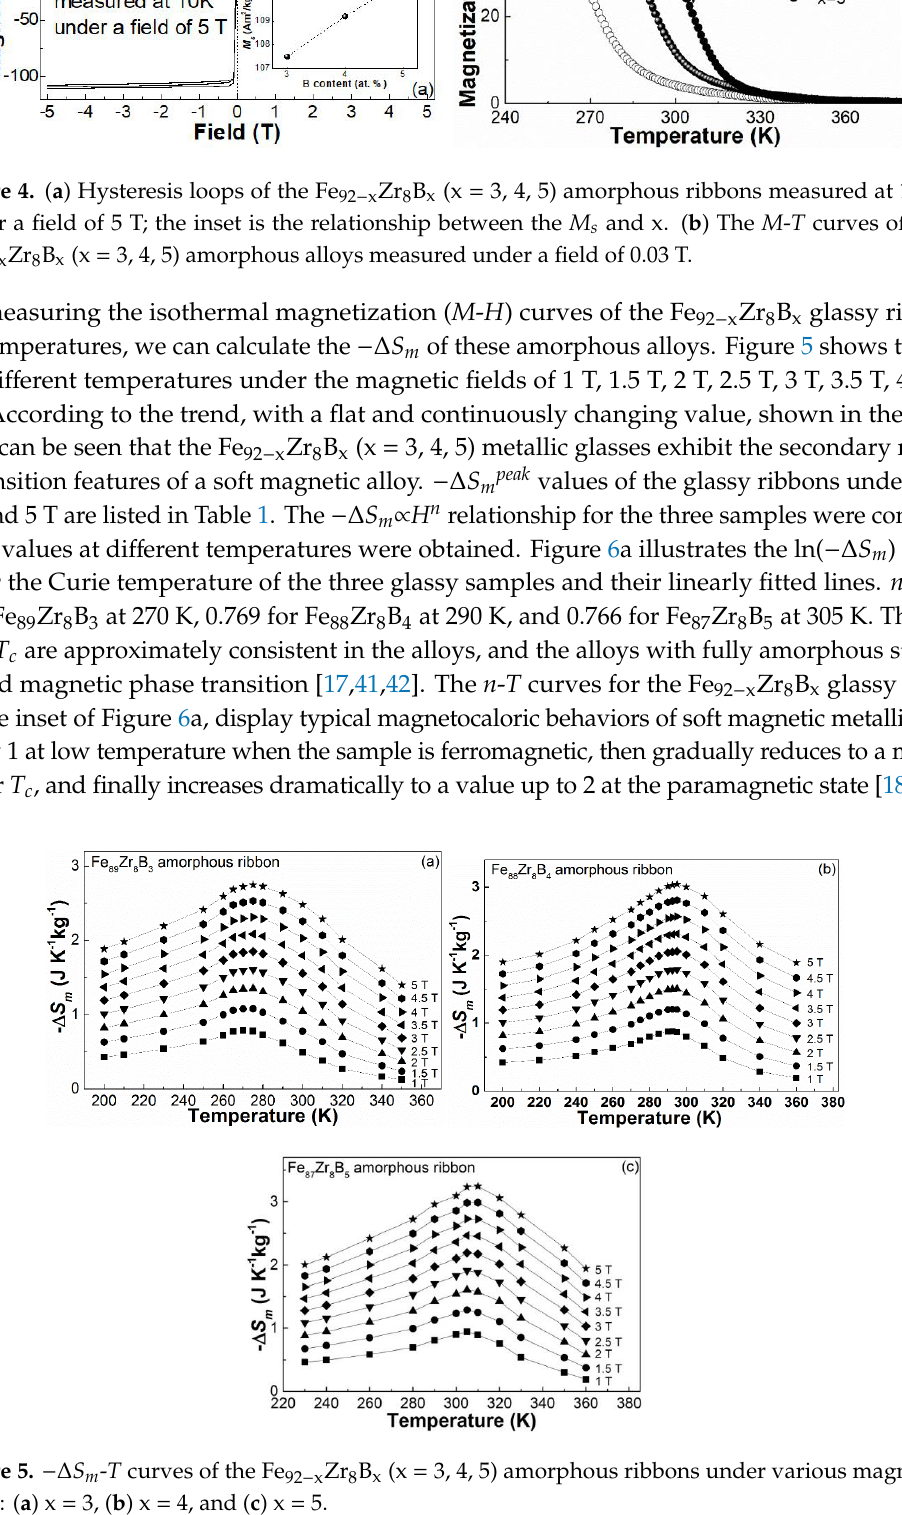
(b) Figure 6. ( a ) The −Δ S mpeak ∝ H n relationship of the Fe 91-x Zr 9 B x (x = 3, 4, 5) amorphous alloys at T c , the inset is the n - T curves of the three amorphous alloys; ( b ) the −Δ S mpeak (under 5 T) vs. T c plots and the linear fitting (dash line) these plots in several Fe-Zr-B-based amorphous samples (listed in Table 1). −Δ S mpeak of Fe 92-x Zr 8 B x amorphous alloys, as predicted above, increases with boron addition: −Δ S mpeak under 5 T at x = 5 is about 6.9% higher than the −Δ S mpeak value at x = 4 and about 18.2% higher the −Δ S mpeak value at x = 3. The increasing −Δ S mpeak as well as M s with boron addition is most likely due to the exciting of free electrons in Fe atoms to a high spin state and thus strengthening the overall magnetic moments by adding of nonmagnetic B element. Therefore, the dependence of −Δ S mpeak on T c of the Fe 92-x Zr 8 B x metallic glasses is contrary to the −Δ S mpeak - T c relationship proposed by Belo et al. [44] in the RE-based glassy samples. The −Δ S mpeak (under 5 T) vs. T c plots in several Fe-Zr-B-based amorphous samples (listed in Table 1), and their linear fitting (dash line) is illustrated in Figure 4b. −Δ S mpeak for these Fe-Zr-B-based glassy ribbons increases monotonically with the Cutie temperature,